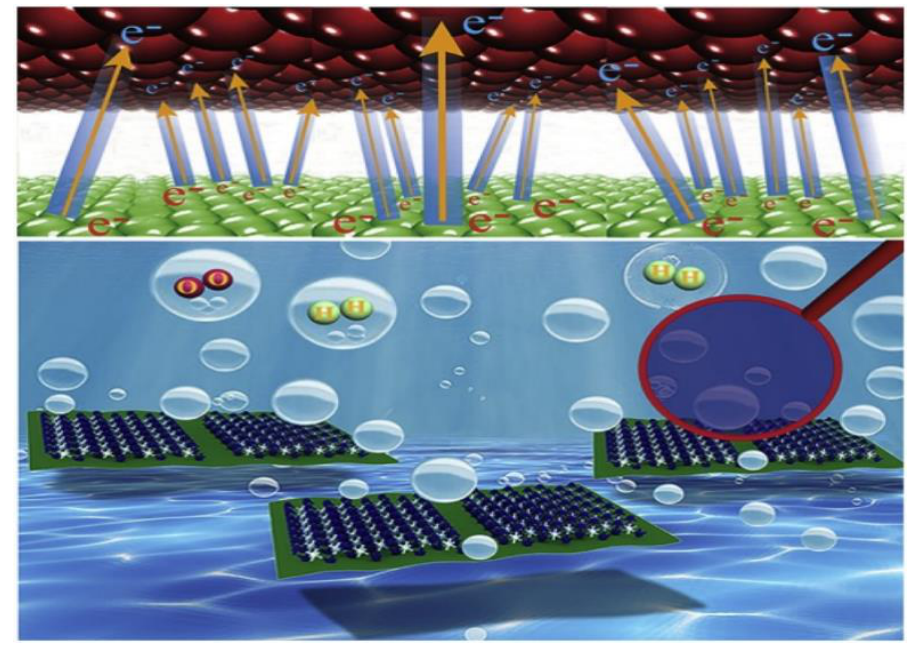
Figure 49. Enhanced photocatalytic reaction at monolithic aerogel interface for stable water splitting reactions (reproduced from the work in [117] with permission).